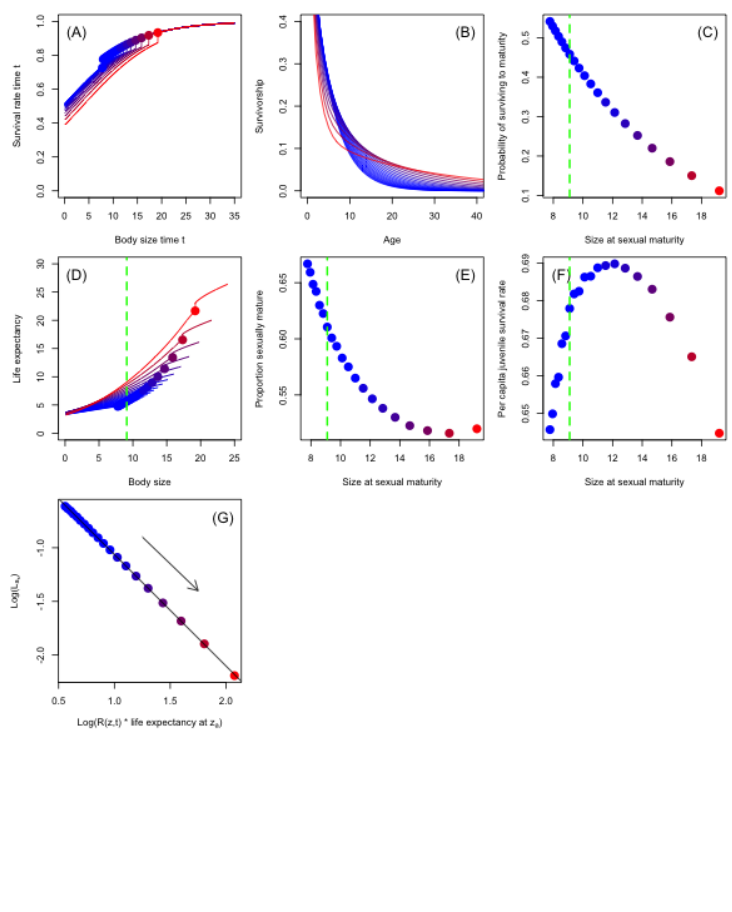
Figure S2. Model structure and outputs when the juvenile survival function is density-dependent (scenario 2). (A) body size-survival function, (B) survivorship functions for each life history, (C) survivorship to sexual maturity as a function of size at sexual maturity, (D) life expectancy as a function of body size, (E) proportion of population that is sexually mature as a function of size at sexual maturity, and (F) per-time step per-capita juvenile survival rate as a function of size at sexual maturity for each life history. (G) linear associations between the log of the density-independent rates against the log of the density-dependent rate (the arrow represents the direction of evolution). The dotted green vertical lines in (C-F) represent the life history of minimum fitness. Each point represents one of our 20 life histories. The redder the colour of a point, the fitter the life history